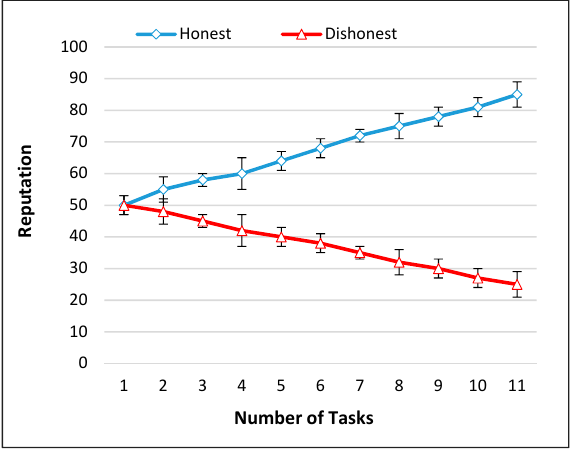
Figure 9. Reputation of honest vs dishonest MWs.